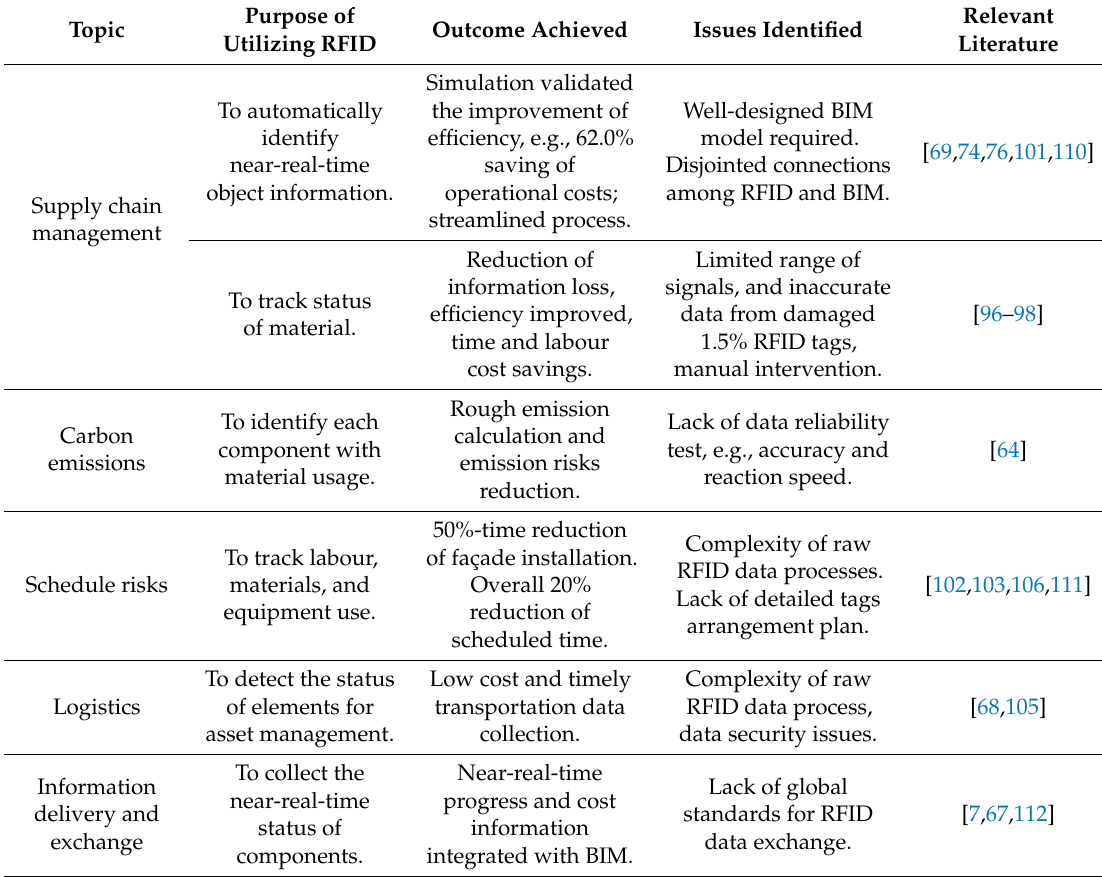
Table 5. Research topics, purpose of radio frequency identification devices (RFID) adoption, and outcomes achieved in previous studies.